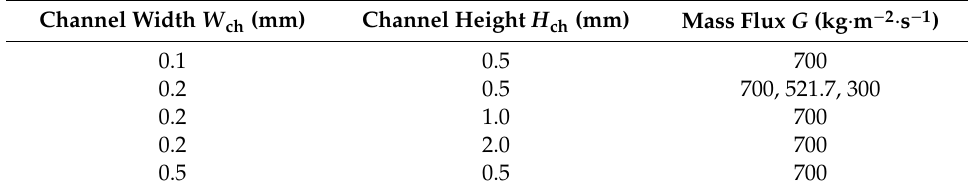
Table 1. Details of computational geometry and operating